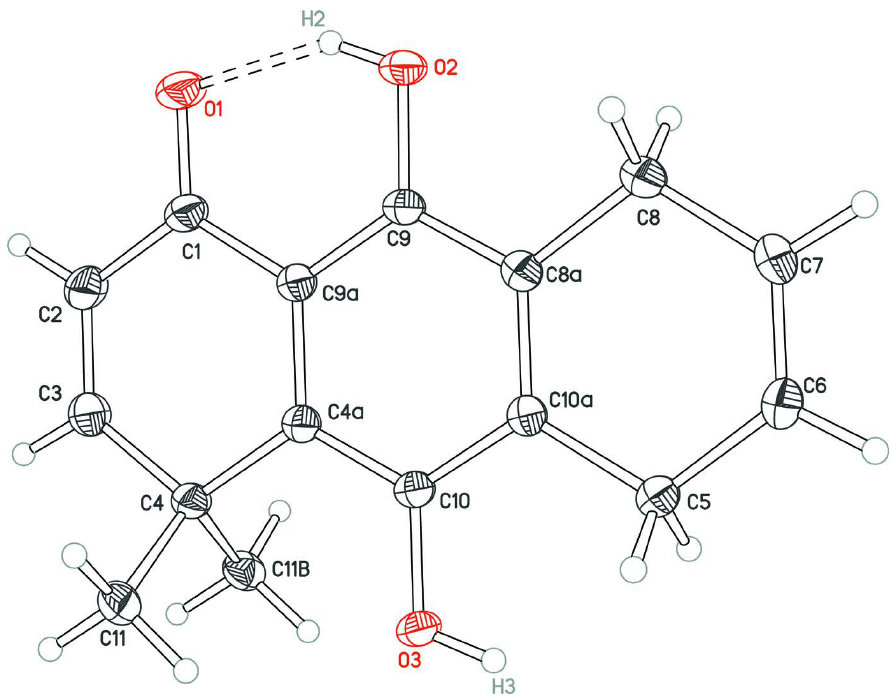
Molecular structure diagramas for I showing atom numbering scheme. Displacement ellipsoids are at 33% probability level and H atoms are shown as spheres of arbitrary radii. Letter a corresponds to the names of fused carbon atoms